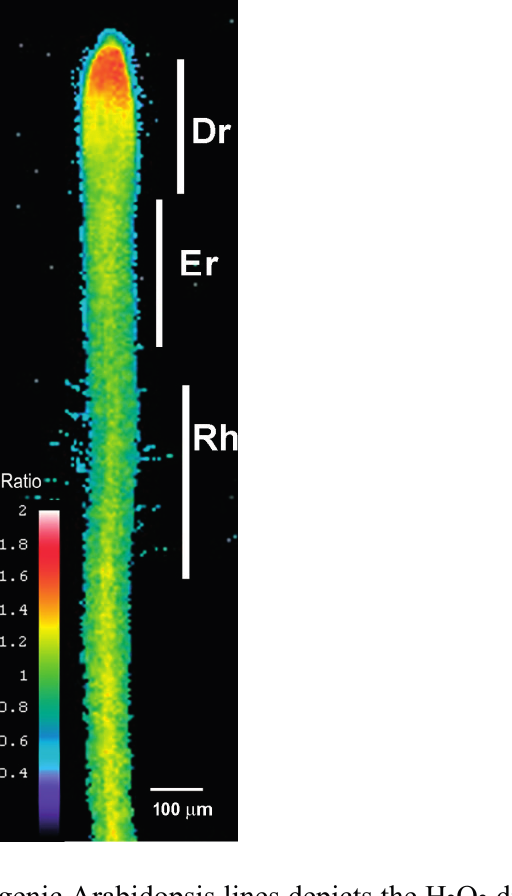
Figure 1. Hyper expression in transgenic Arabidopsis lines depicts the H 2 O 2 distribution in the growing root. Note the high H 2 O 2 levels in the root tip region where cell division occurs (Dr) and the lower levels in the elongation zone (Er) and root hairs at the root hair emerging zone